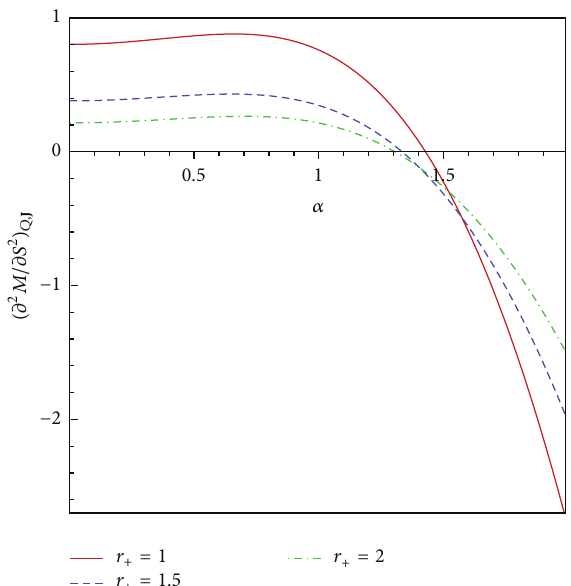
Figure 3: The behavior of (𝜕 2 𝑀/𝜕𝑆 2 ) 𝑄, J versus 𝛼 with 𝑙 = 𝑏 = 1 , 𝑞 = 0.8 , Ξ = 1.25 , 𝑛 = 5 , and 𝛽 = 2 .